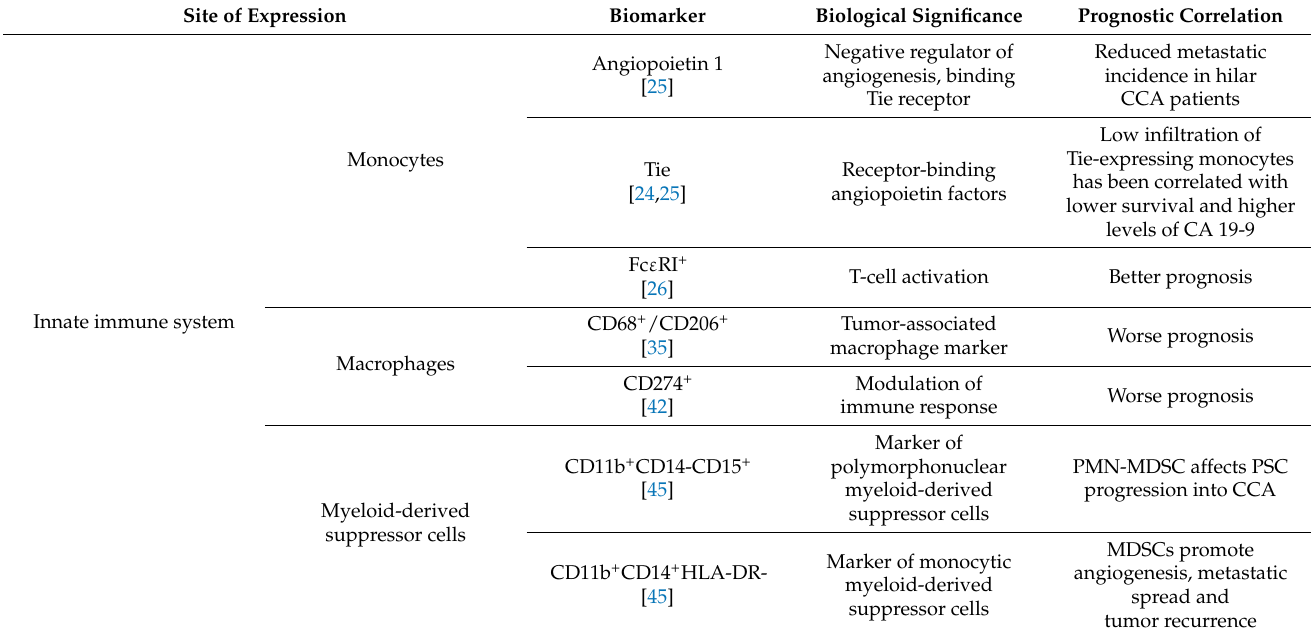
Table 2. The main components of the tumor microenvironment in cholangiocarcinoma, its biological significance and prognosis